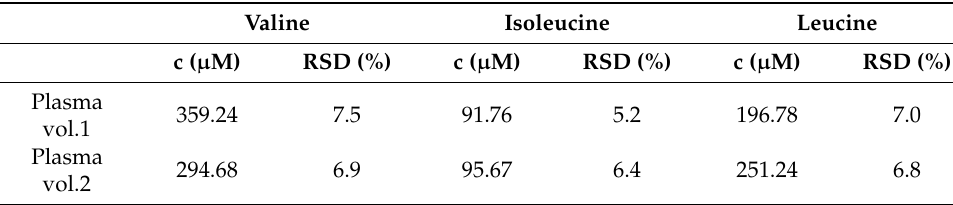
Table 11. Determined concentrations of BCAAs in tested plasma